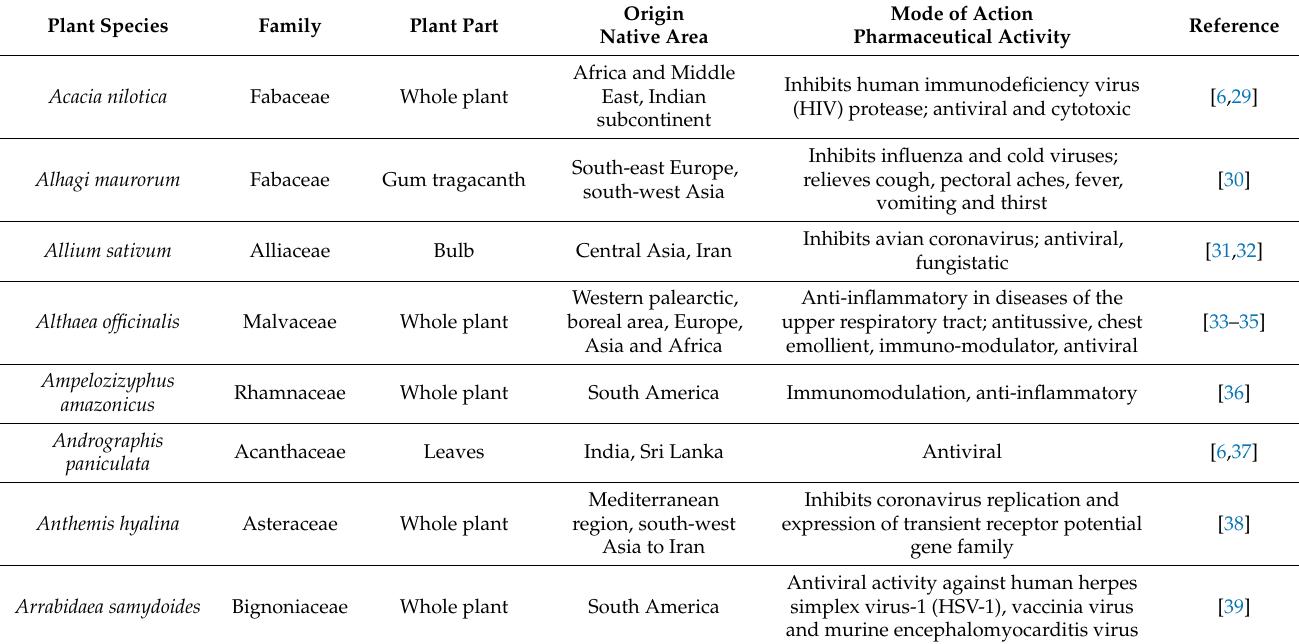
Table 1. Description of medicinal plants and crops and their antiviral activity. The abbreviations of the authors of the scientific names have been omitted for the sake of clarity (see